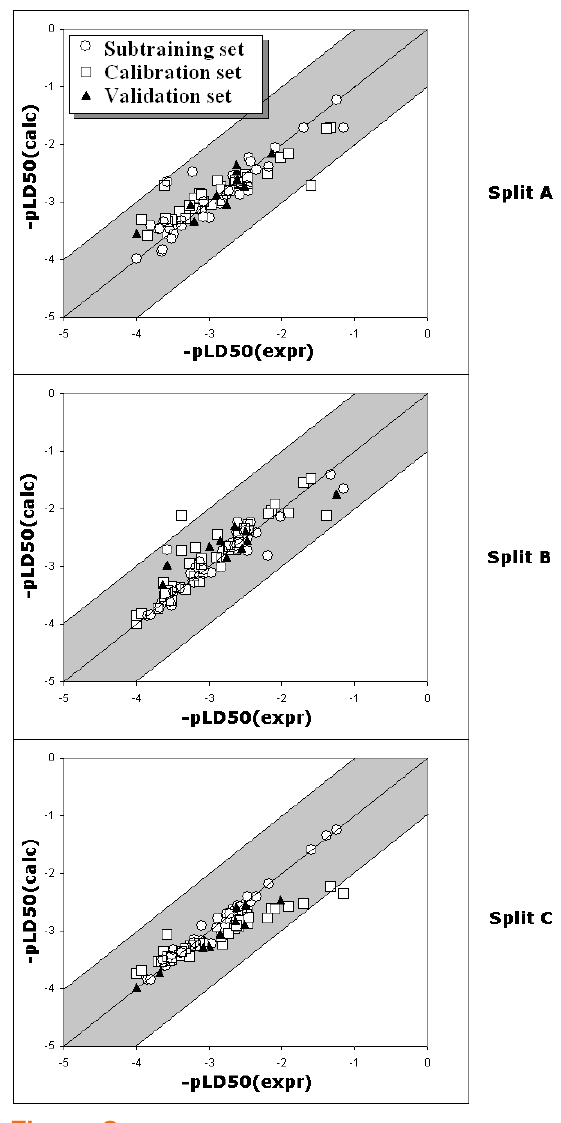
Figure 2. Graphical representation of –pLD50 models for split A, split B, and split